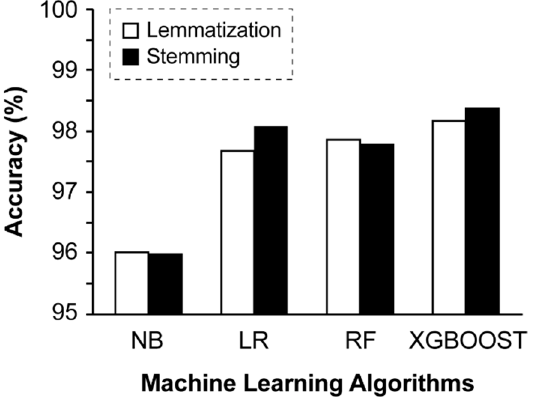
Figure 8. Impact of lemmatization and stemming on performance of Naïve Bayes (NB), Logistic Regression (LR), Random Forest (RF), and Extreme Gradient Boosting (XGBOOST)-based machine learning algorithms.